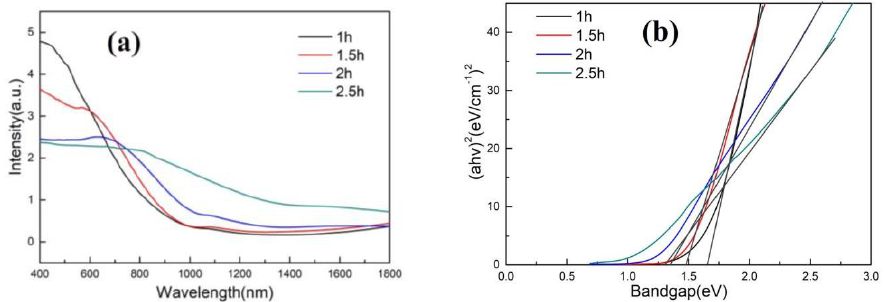
Figure 3. ( a ) UV-Vis di ff use reflection spectra of CdTe thin films with deposition time of 1 h, 1.5 h, 2 h, and 2.5 h, respectively; ( b ) CdTe band gap patterns with deposition time of 1 h, 1.5 h, 2 h, and 2.5 h, respectively.